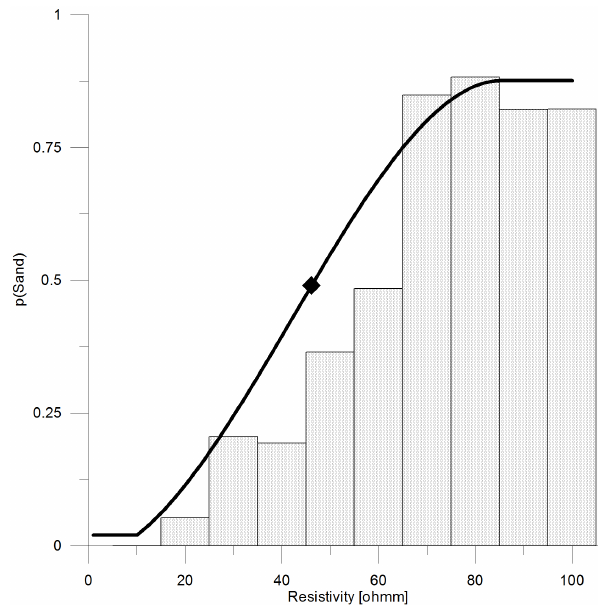
Figure 5. The bias-corrected histogram curve: the calibrated cut- off value (46 (cid:127) m) is added to the histogram and the fitted curve is forced to honor it (He et al.,